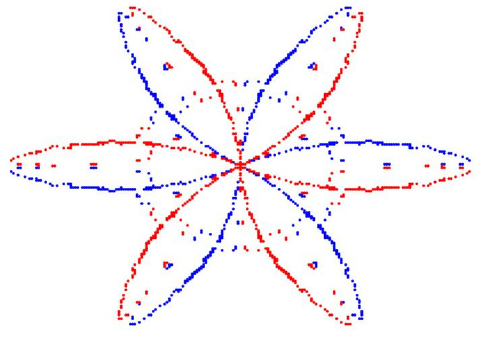
Figure 10. Snowflake image of the normal PV module .